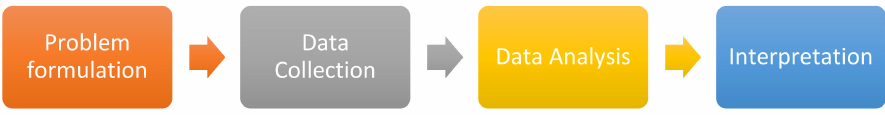
Figure 1. Our approach steps.